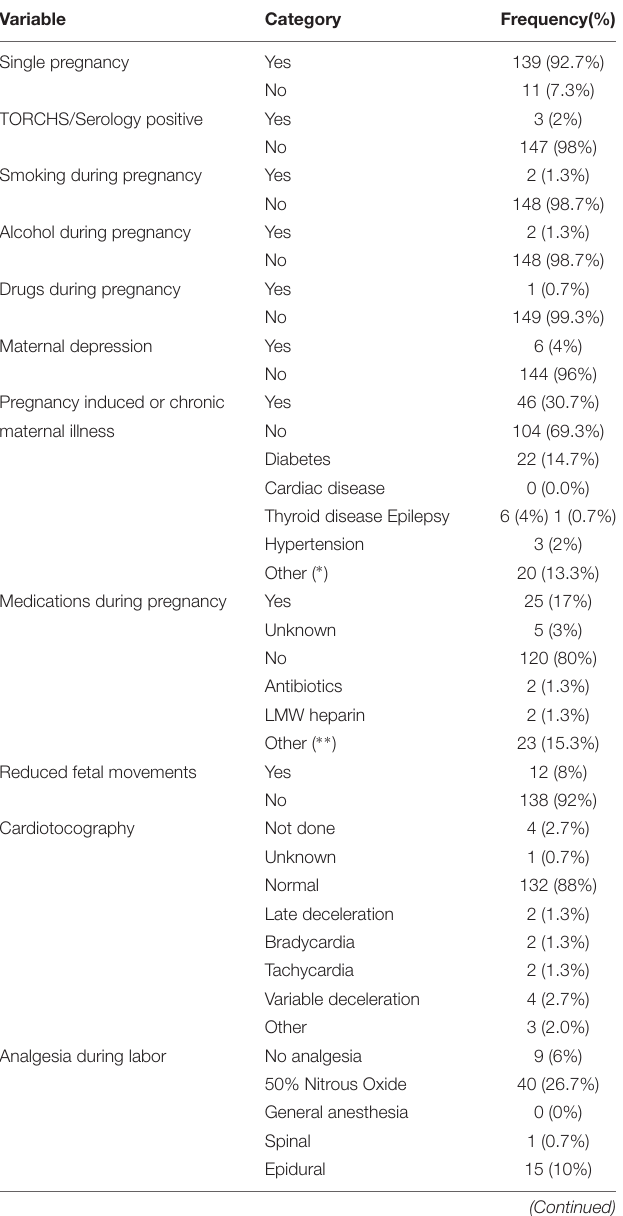
TABLE 3 | Sample characteristics II (categorical